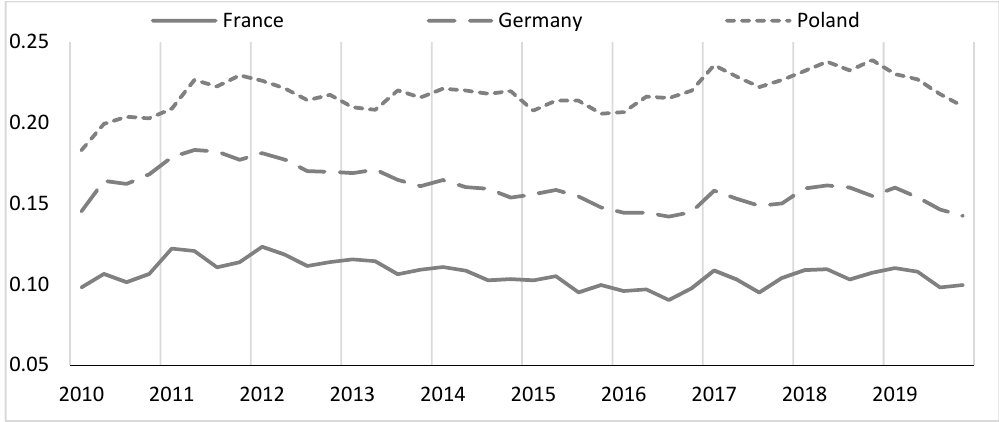
Figure 6. Import intensity of private investment, own work, source: Eurostat. J. Risk Financial Manag. 2020 , 13 , x FOR PEER REVIEW